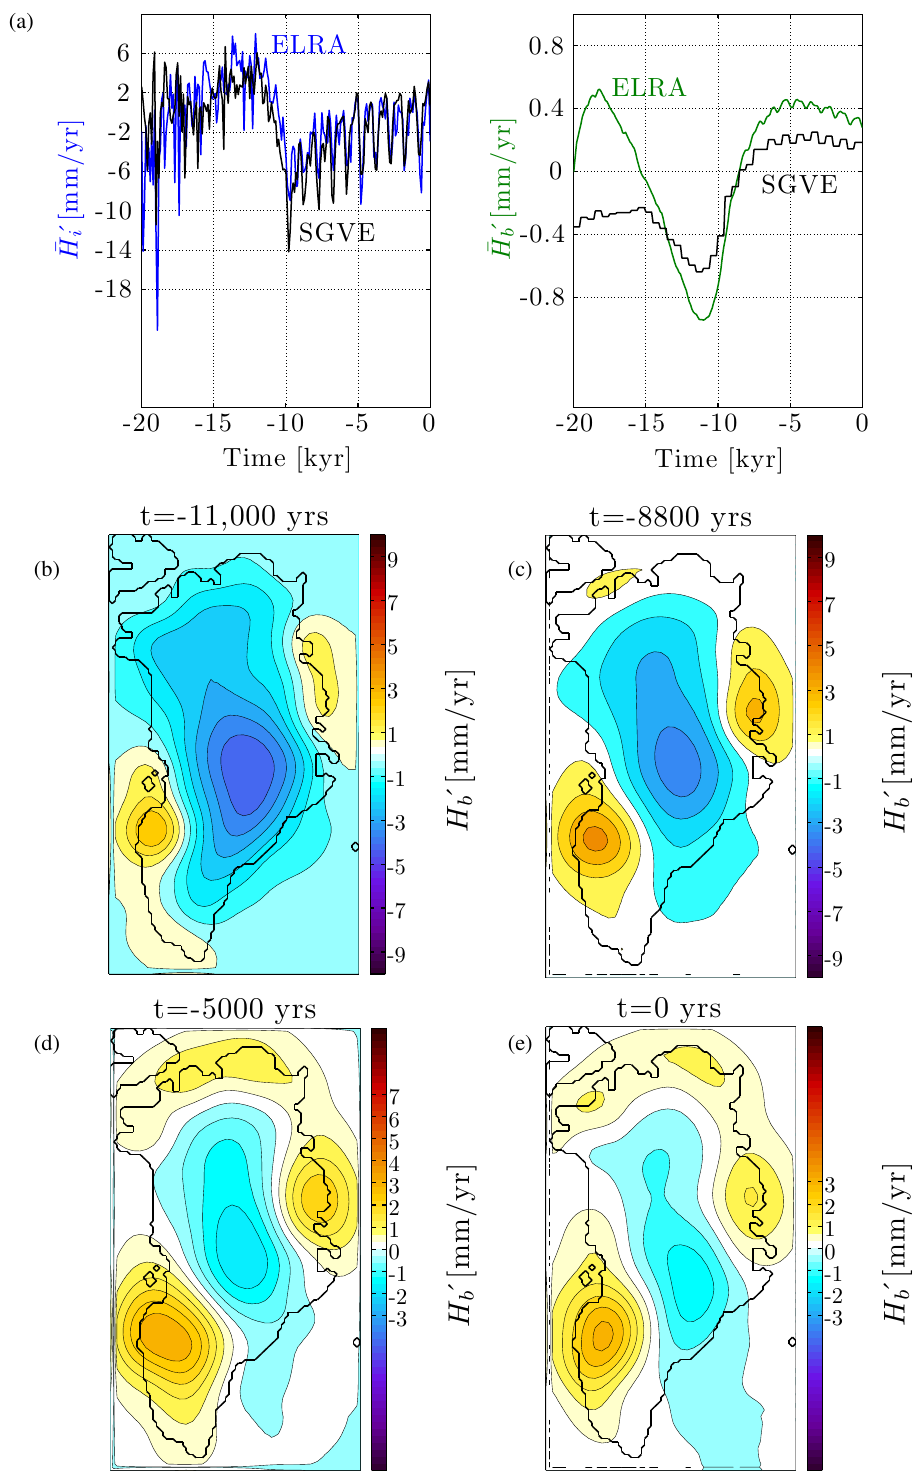
Fig. 3. (a) Comparison between values of ¯ H 0 i and ¯ H 0 obtained with the ELRA and SGVE models showing qualitatively similar results. (b-e) Patterns of H 0 with the SGVE model for the selected time points in Fig. 2a for (b) the maximum subsidence, (c) and (d) moments when the strong subsidence at the center starts to fade, and (e) present-day conditions, characterized by an average bedrock uplift.